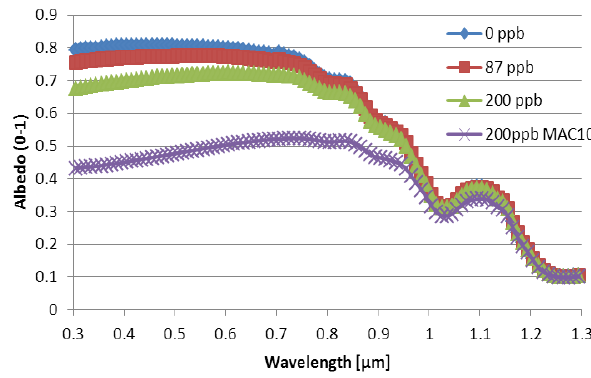
Fig. 10. The SNICAR online simulated snow albedo spectra at 0.3– 1.3µm (clear sky at SZA = 55 degrees, grain radius 1.5mm, snow depth 10cm, snow density 350 kgm − 3 ) demonstrate that the ab- sorption caused by impurities in snow is greater the shorter the wavelength, compared to clean snow (blue). The EC in snow de- termined by the thermo–optical method was 87ppb (red). The snow BC concentration was assumed to be approx. double the EC con- centration determined by the thermo–optical method (green). Intro- ducing a mass absorption coefficient MAC = 10 produced albedo values close to the lowest measured albedo of ∼ 0.4–0.5 at UV (pur-